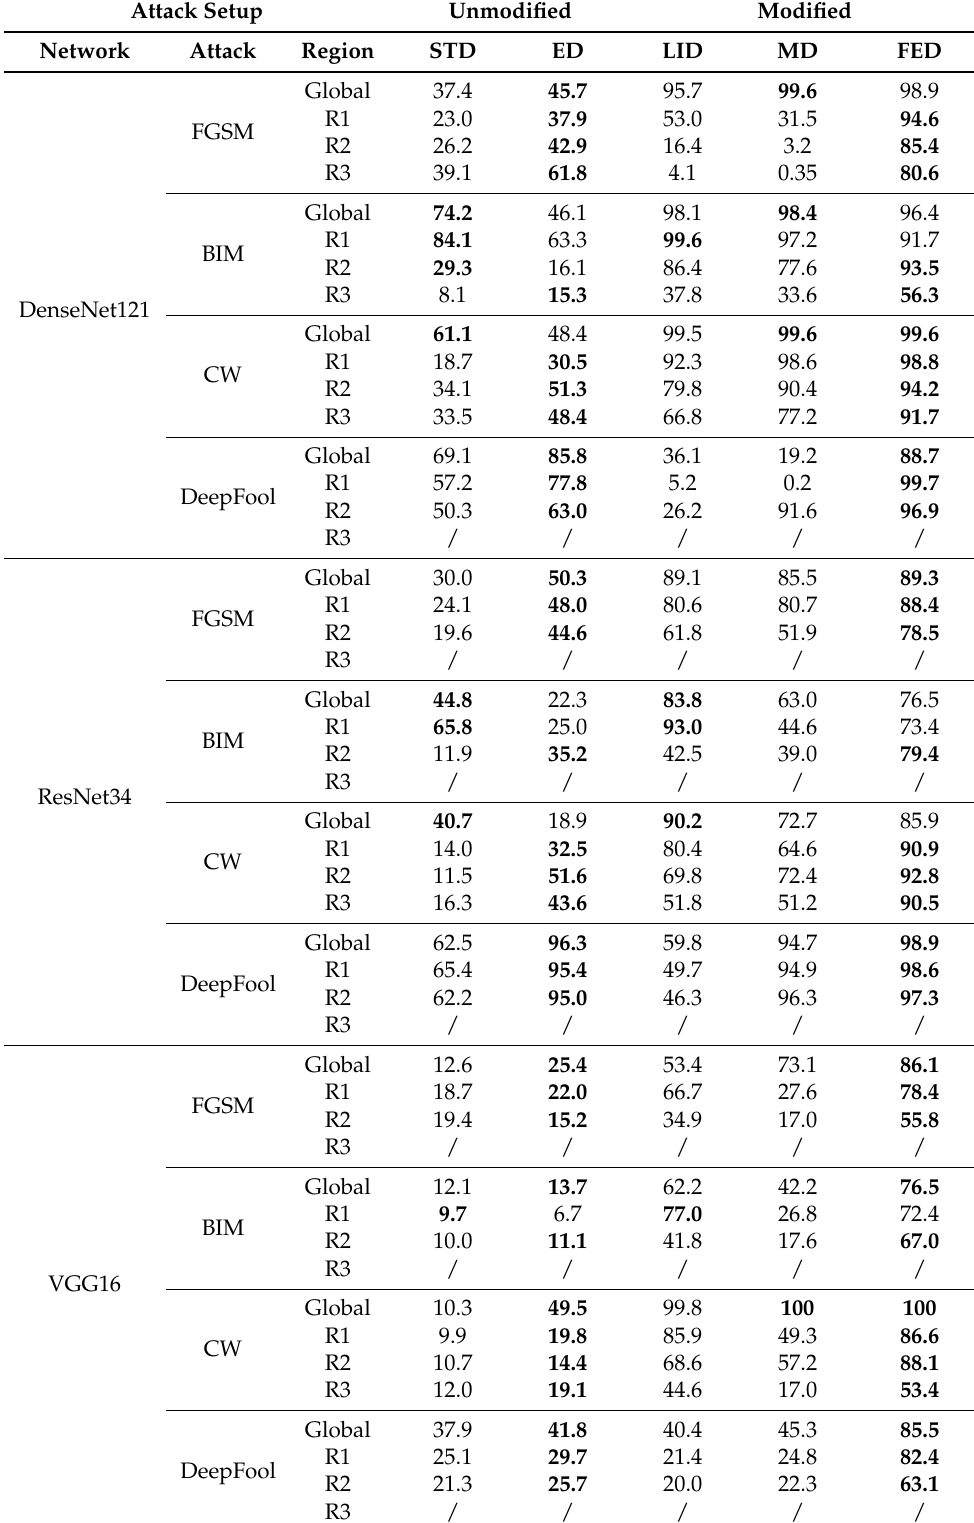
Table 4. Comparison of the TNR@95%TPR against SAR AEs between the proposed methods and classic methods